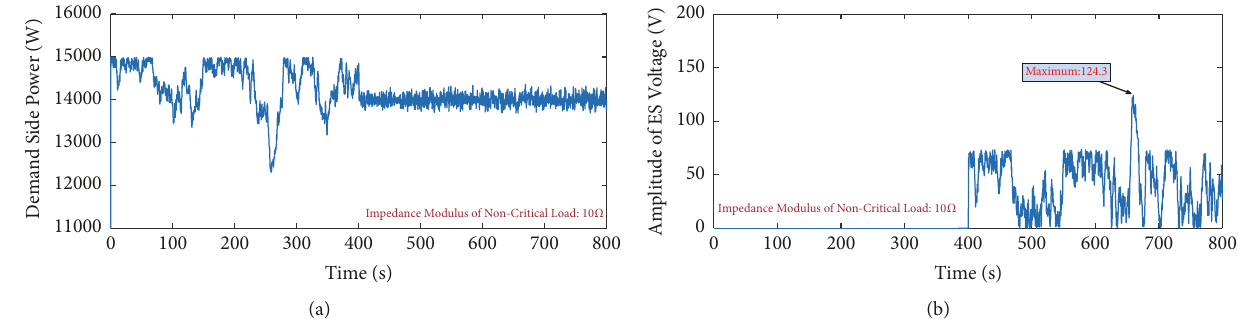
Figure 18: ES in series with a 10 Ω noncritical load. (a) Demand side power. (b) The amplitude of ES voltage.